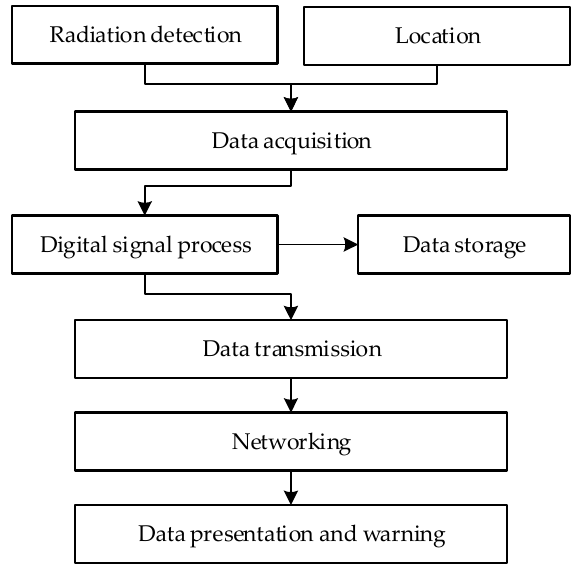
Figure 10. Logical block diagram of the working process of the proposed detection system.